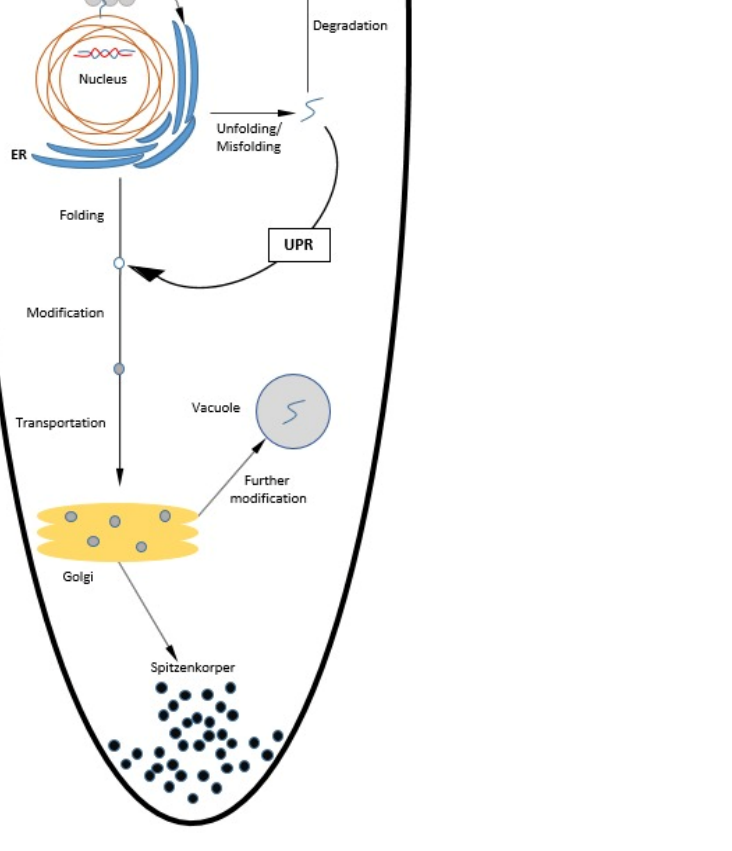
Figure 1. Secretory pathway of filamentous fungi. The main pathways and bottlenecks are illustrated. ER—endoplasmic reticulum; ERAD—endoplasmic reticulum-associated degradation; SRP—signal recognition particle; UPR—unfolded protein response.